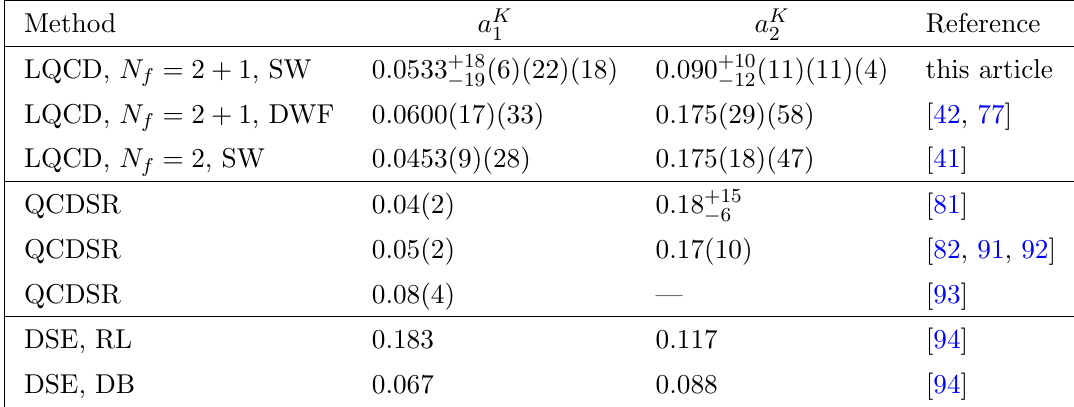
Table 5 . The (cid:12)rst two Gegenbauer moments of the kaon LCDA at the MS scale (cid:22) = 2 GeV. The abbreviations have been explained in the caption of table